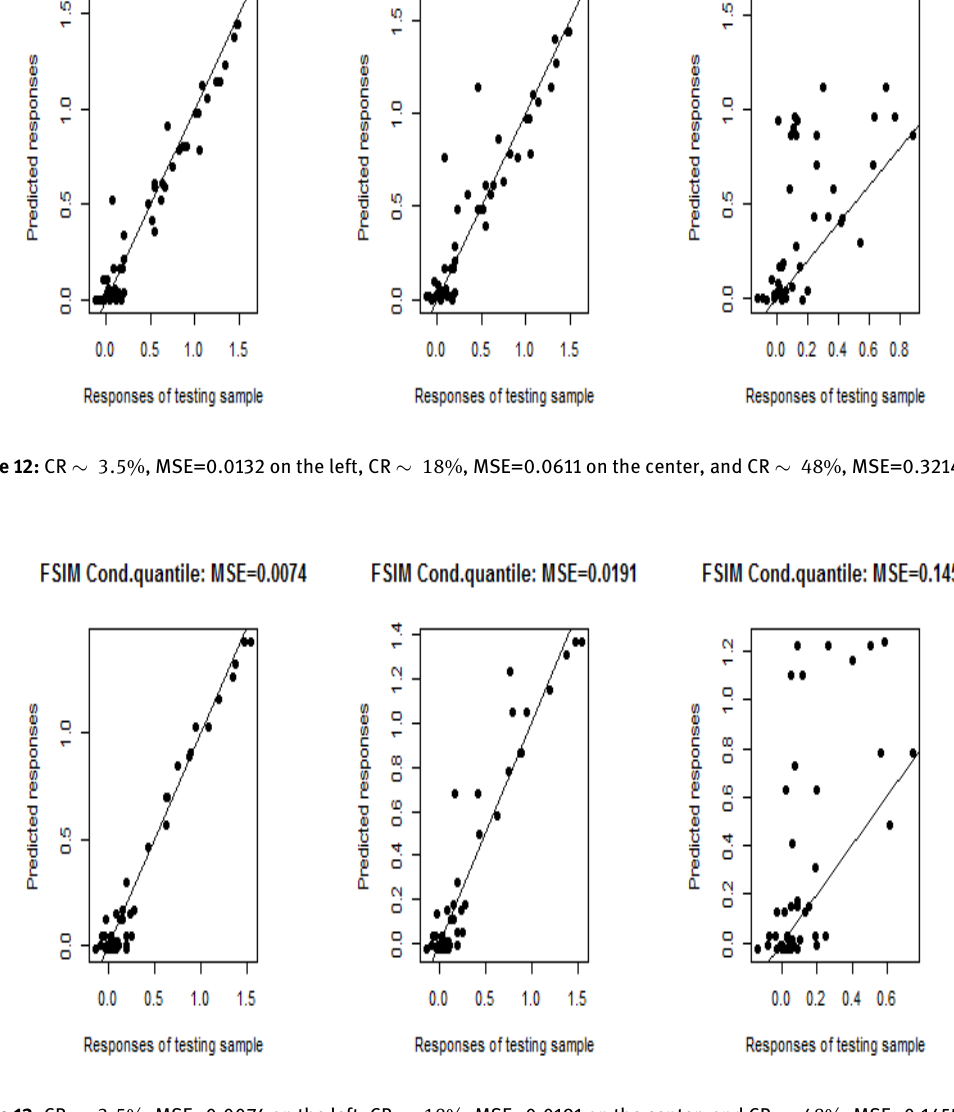
Figure 13: CR ∼ 3.5% , MSE=0.0074 on the left, CR ∼ 18% , MSE=0.0191 on the center, and CR ∼ 48% , MSE=0.1455 on the right